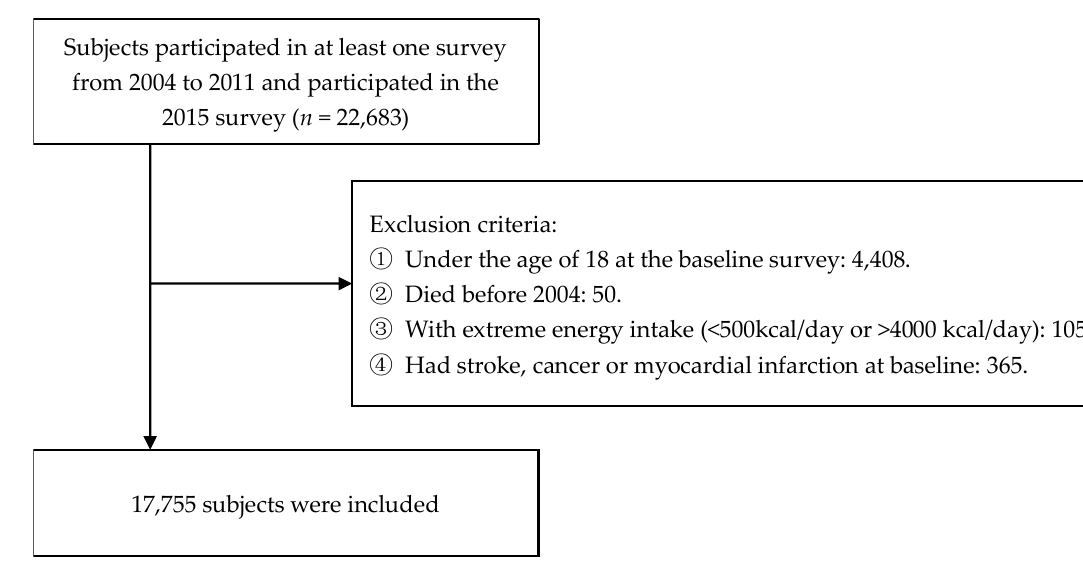
Figure 1. Flow chart of subject exclusion.